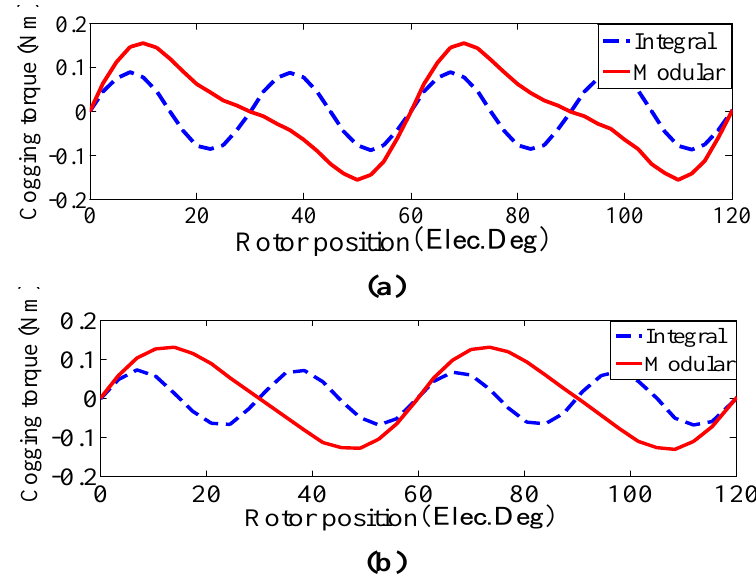
Figure 10. Cogging torques versus rotor. ( a ) 12s / 10p; ( b ) 12s / 14p.